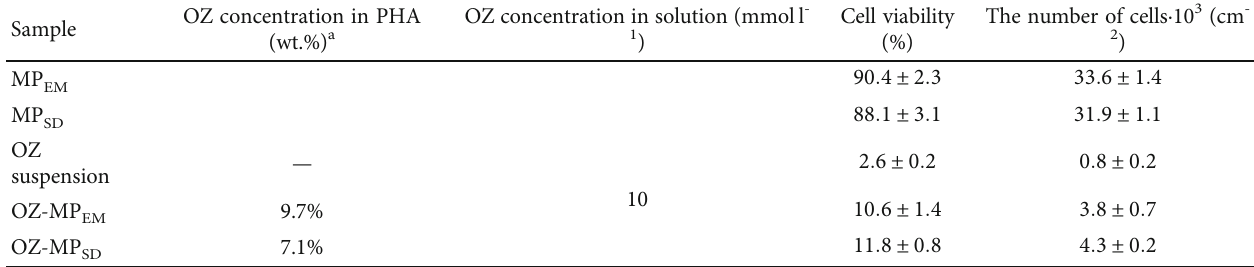
Table 4: The cell viability (microparticles).